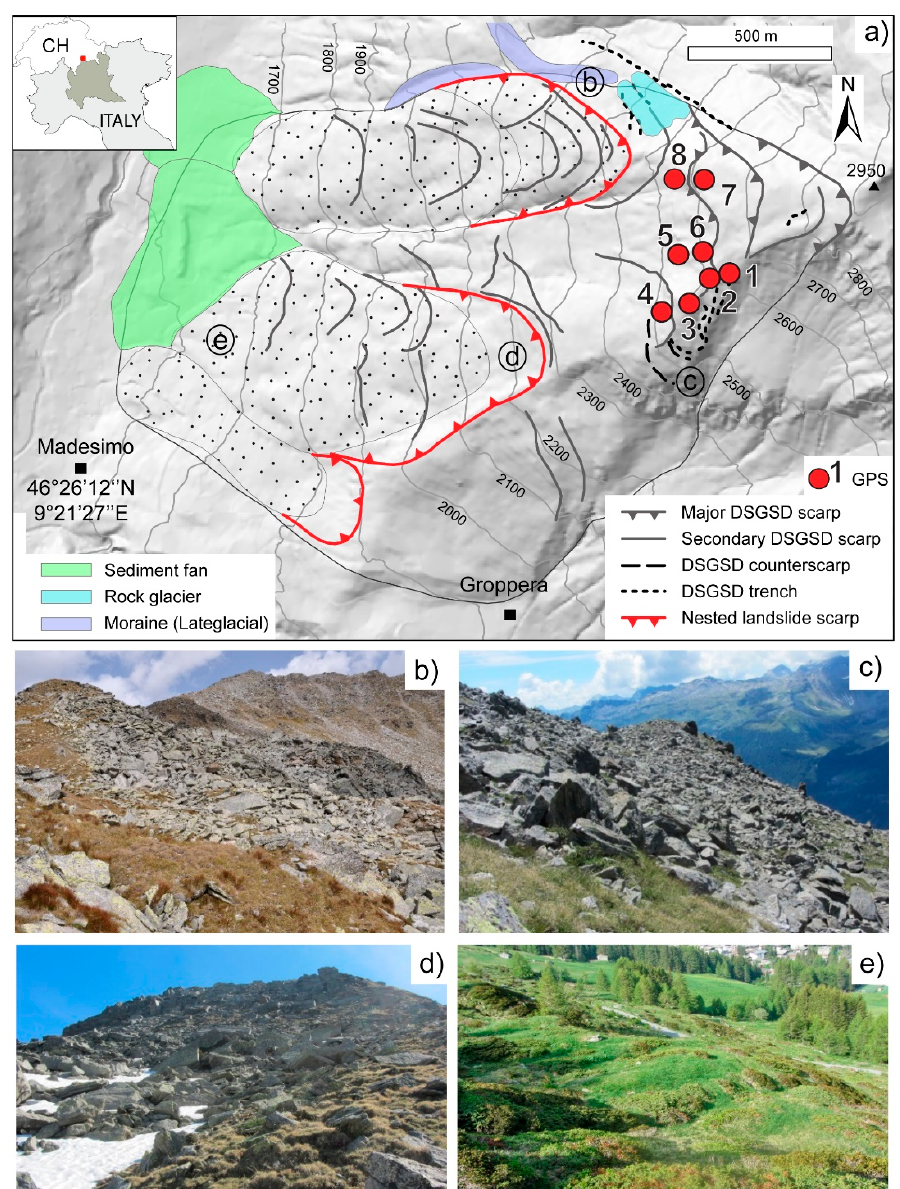
Figure 1. Main features of the Mt. Mater deep-seated gravitational slope deformation (DSGSD). ( a ) Simplified map portraying the main morpho-structural features associated with DSGSD and nested large landslides. GPS benchmark locations are outlined. ( b ) tranches on the S side of the main DSGSD body; ( c ) main scarp of the northern nested landslide (cross-section in Figure 6); ( d ) damaged rock mass at the top of the southern nested landslide; ( e ) blocky accumulation at the southern nested landslide toe.